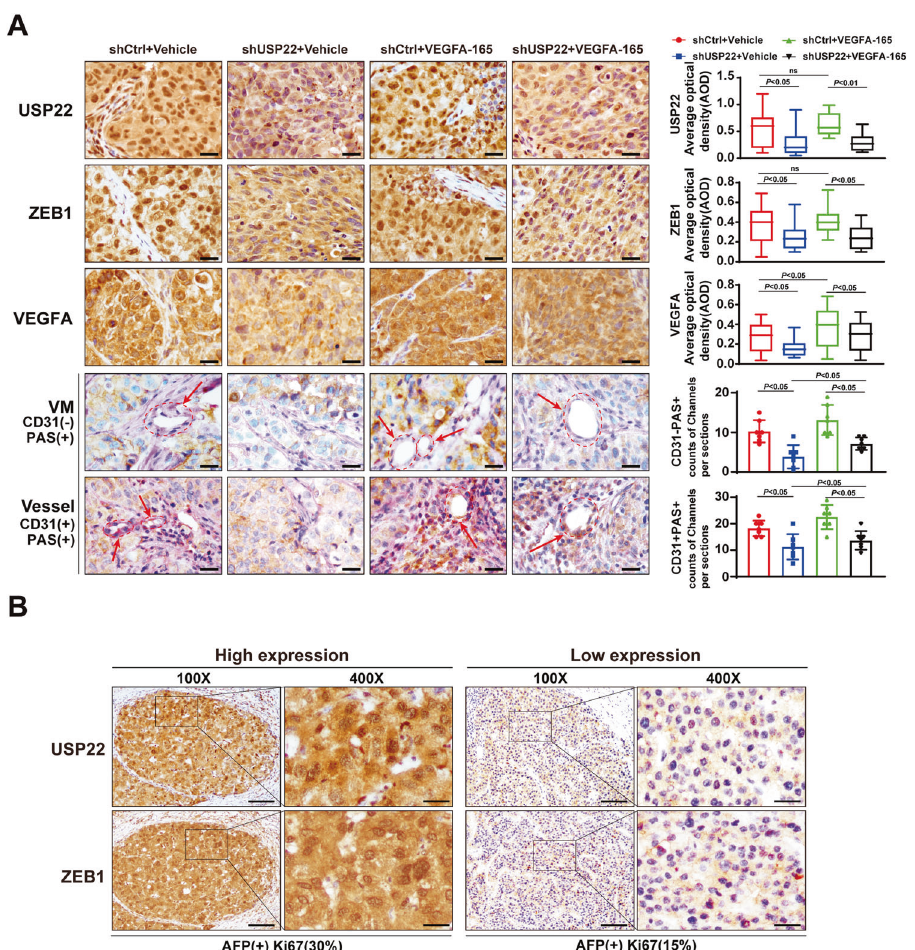
Fig. 7 Knockdown of USP22 reduced VM formation in xenograft tumors. A Expression of USP22, ZEB1 and VEGFA in xenograft tumors (Fig. 6A) were detected by IHC assays; CD31/PAS double staining was used to evaluate the appearance of vasculogenic mimicry (PAS + CD31-) and vessels (PAS + and CD31 + ) in the shUSP22 and shCtrl groups. VEGFA-165 stands for recombinant human protein VEGFA-165. Scale bars, 50 μ m. Average optical density (AOD) was used to evaluate the relative expression levels of USP22, ZEB1 and VEGFA. Counts of channels per sections was used to evaluate the effect of USP22 on the formation of vascular mimicry and angiogenesis within tumors. B The representative images of expression of USP22 and ZEB1 in immunohistochemical staining of human HCC pathological sections. The expression of speci fi c marker from the HCC pathological data showed that, the tumor with high USP22 and ZEB1 expression on the left, AFP ( + ), Ki67(30%); the tumor with low USP22 and ZEB1 expression on the right, AFP ( + ), Ki67 (15%). Scale bars, 200 μ